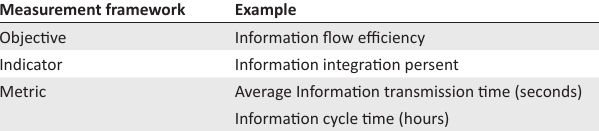
TABLE 1: Information flow efficiency measurement framework. Measurement framework